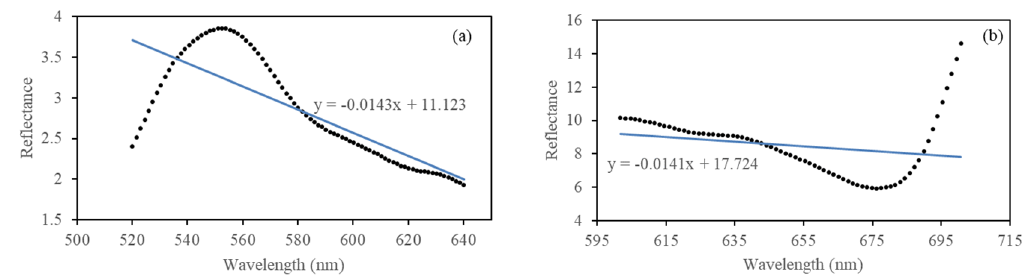
Figure 6. ( a ) The reflectance and wavelength corresponding to RCRW 520–640 ; ( b ) the reflectance and wavelength corresponding to RCRW 600–700 .